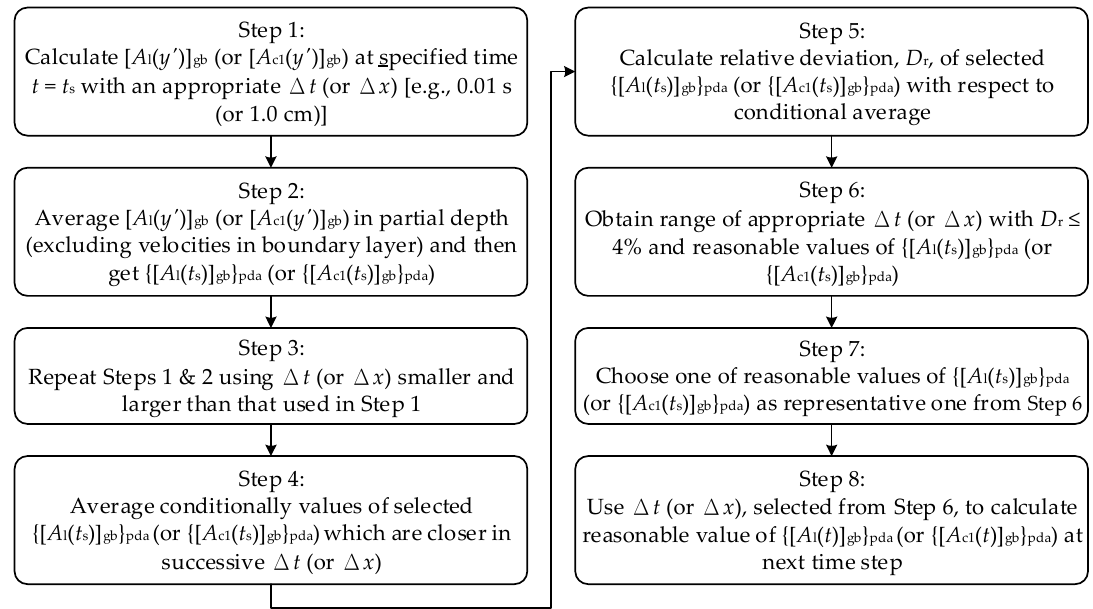
Figure 17. Flow chart showing calculation process to determine promising value of {[ A l ( t )] gb } pda or {[ A cl ( t )] gb } pda .